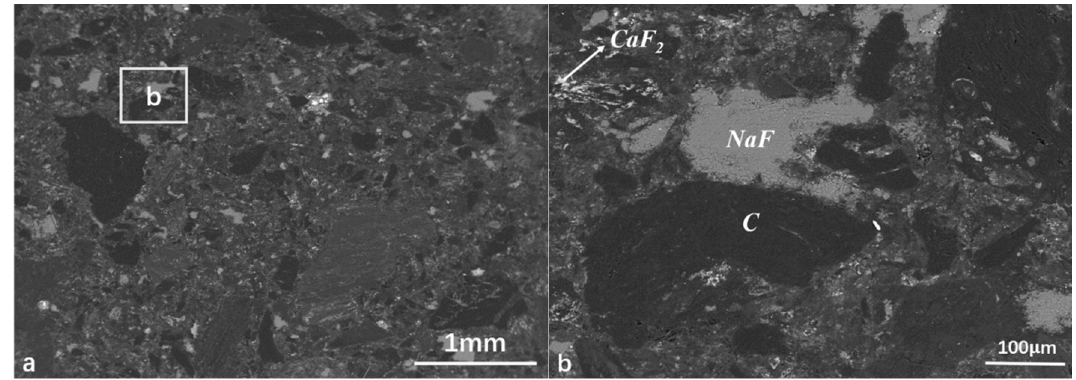
Figure 2. SEM-EDS analysis of SPL-1cut. ( a ) the microstructure of SPL-1cut; ( b ) enlarged view of the b area.